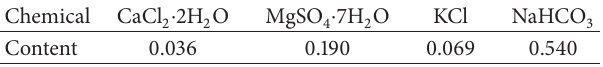
Table 3: Chemical composition in simulated soil solutions